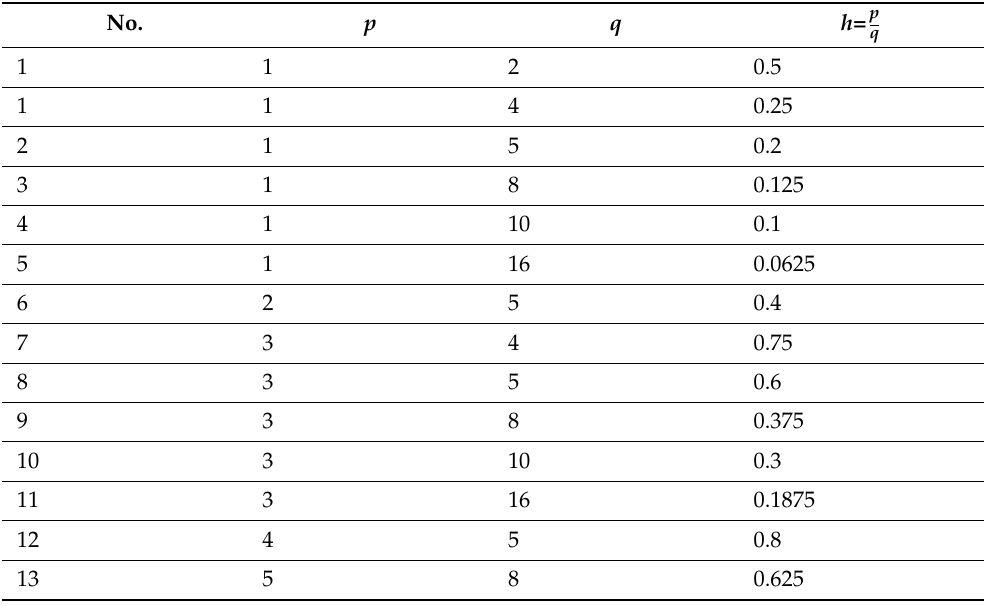
Table 2. CPM Modulation